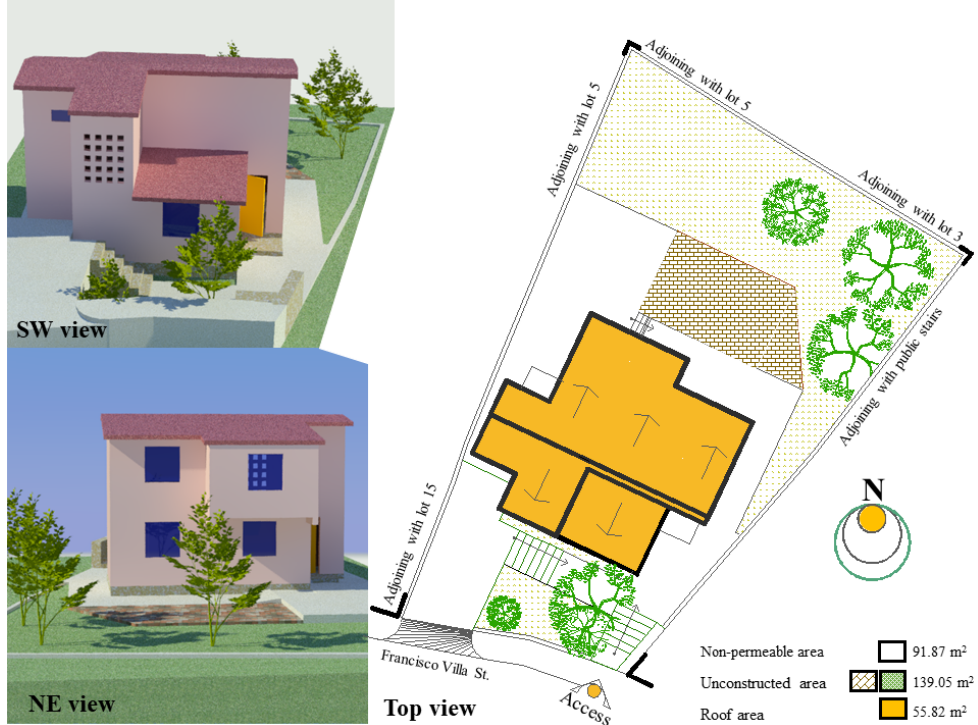
Figure 3. Single-family household diagram.